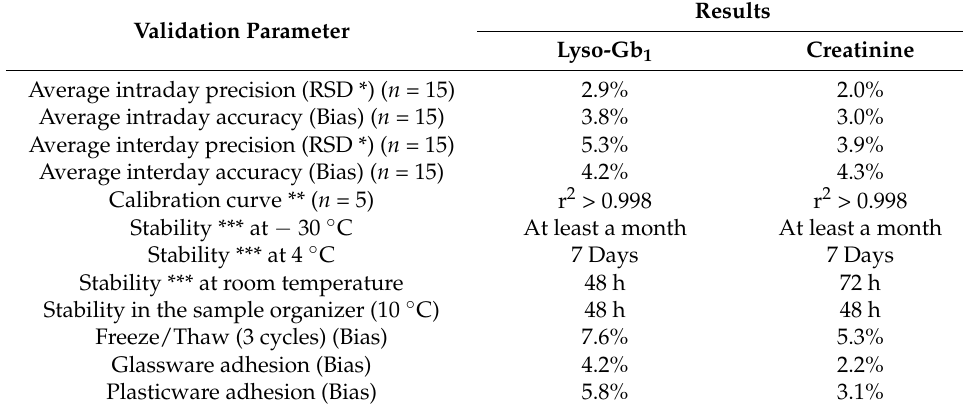
Table 2. Method validation parameters using lyso-Gb 1 and creatinine